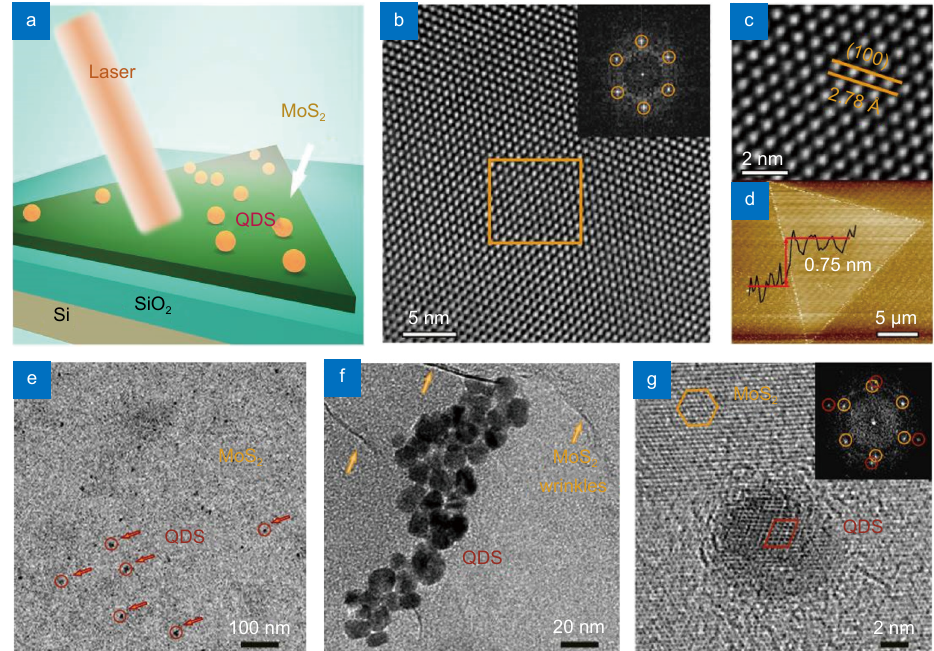
Fig. 1 | Schematic view and TEM characterizations of MoS 2 monolayer and CdSe/ZnS QDs. ( a ) Schematic view of mixed-dimensional QD/MoS 2 heterostructures on SiO 2 /Si substrate under the excitation of a laser. ( b ) High-resolution TEM (HRTEM) image of MoS 2 monolayer with the scale bar of 5 nm. The inset shows the corresponding selected area electron diffraction (SAED) pattern, where the diffraction points are ar- ranged in a hexagonal structure. ( c ) Enlarged FFT image of the marked area in a rectangular region in (b). The lattice spacing is 2.78 Å. ( d ) The AFM image of MoS 2 monolayer with clear surface, and the height of MoS 2 is observed to be 0.75 nm. Low-resolution ( e ) and high-resolution ( f ) TEM images of QD/MoS 2 heterostructures, where scale bars are 100 nm and 20 nm, respectively. The red arrows and circles in (e) are QDs on MoS 2 monolayer, and the orange arrows in (f) are the wrinkles of MoS 2 flakes. ( g ) The HRTEM image of QD/MoS 2 structures with a scale bar of 2 nm. Inset shows two sets of SAED